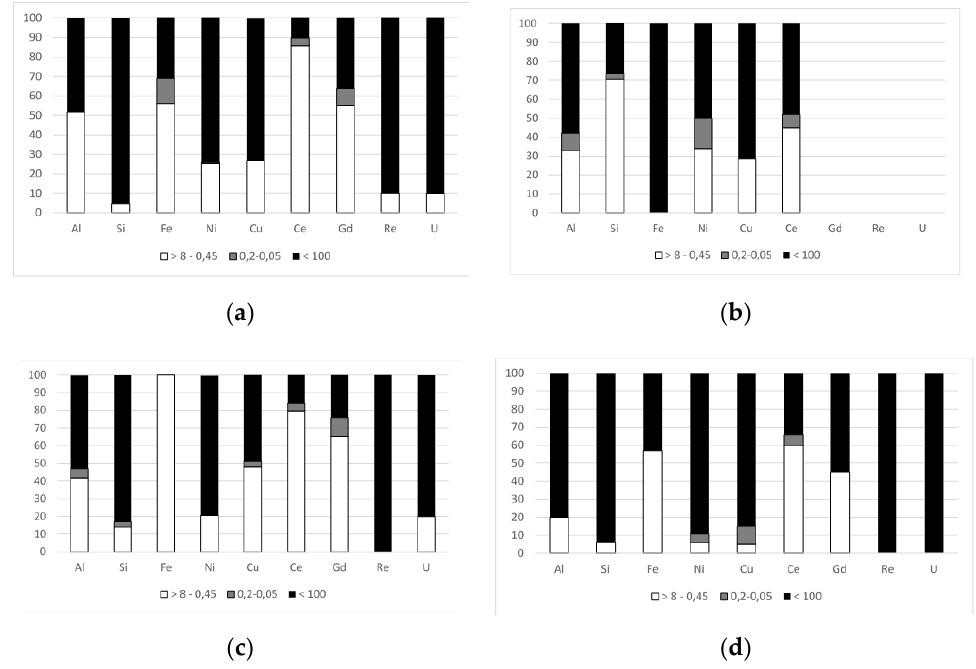
Figure 2. The content of elements by fractions (%): ( a ) Kumuzhiy (surface); ( b ) Kumuzhiy (near-bottom); ( c ) Monche (surface); ( d ) Monche (near-bottom).